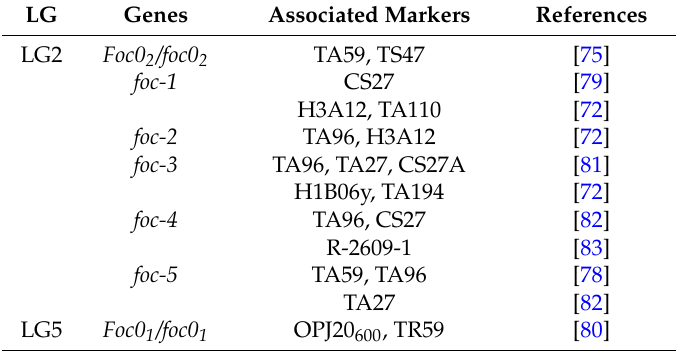
Table 1. Associated markers for genes resistant to various Foc races in different linkage groups of the chickpea genetic map. LG Genes Associated